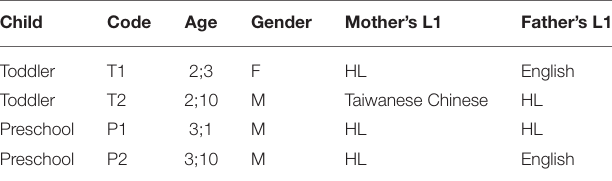
TABLE 1 | Background information for the children in the present